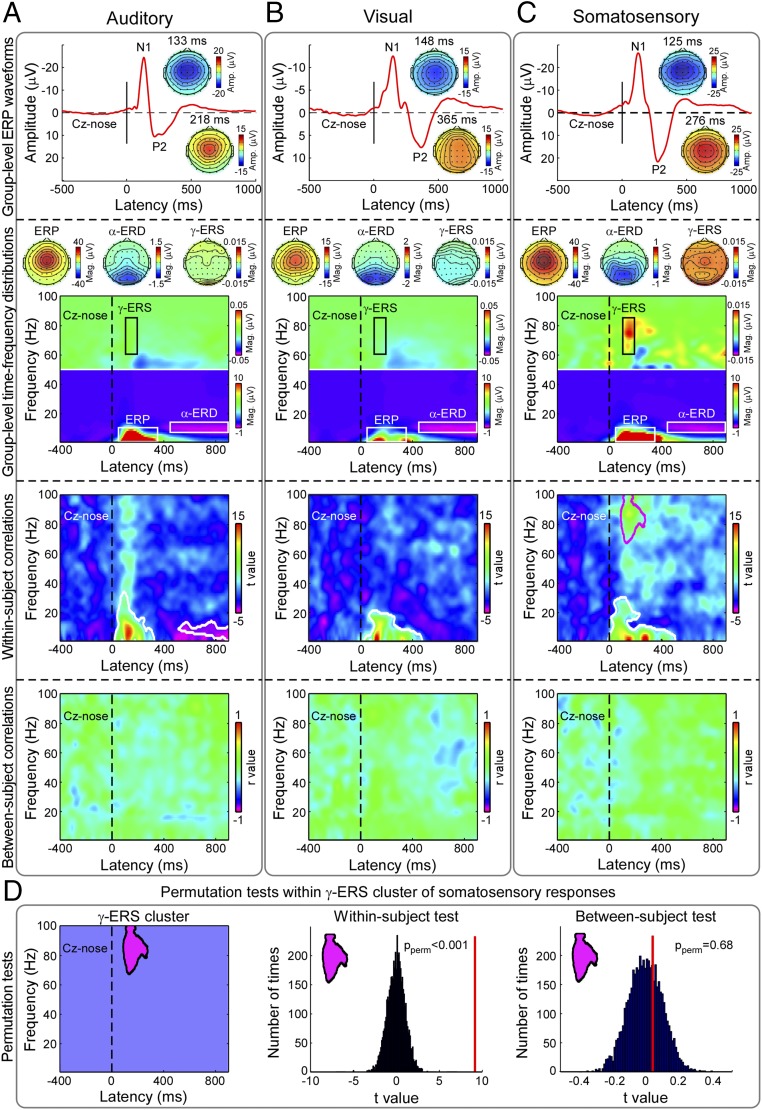
Experiment 2. EEG indicators of within-subject and between-subject variability in intensity ratings to auditory, visual, and nonnociceptive somatosensory stimuli (columns A, B, and C, respectively). Group-level ERP waveforms together with the scalp topographies of N1 and P2 waves are displayed in the First Row. Note the similarity of scalp distribution of the main negative and positive response peaks. Group-level TFDs of single-trial auditory, visual, and somatosensory responses are displayed in the Second Row, together with the scalp topographies of ERP, α-ERD, and γ-ERS. In all sensory modalities, the scalp topographies of ERP and α-ERD were maximal at central and occipital regions, respectively. Only somatosensory stimuli elicited a clear γ-ERS response, with a scalp distribution maximal at central electrodes. Time-frequency clusters reflecting the within-subject variability in intensity ratings are outlined in white or purple (Third Row; auditory: 20 to 324 ms, 1 to 34 Hz; 512 to 900 ms, 2 to 14 Hz; visual: 26 to 472 ms, 1 to 22 Hz; somatosensory: 0 to 506 ms, 1 to 30 Hz; 86 to 276 ms, 68 to 100 Hz). No time-frequency cluster reflected the between-subject variability in intensity ratings, in any sensory modality (Fourth Row). (D) The γ-ERS elicited by somatosensory stimuli reflected within-subject variability in intensity ratings (t-value, vertical red line in the middle plot; P < 0.001; 5,000 permutations), but not the between-subject variability in intensity ratings (r-value, vertical red line in the right plot; P = 0.68; 5,000 permutations).